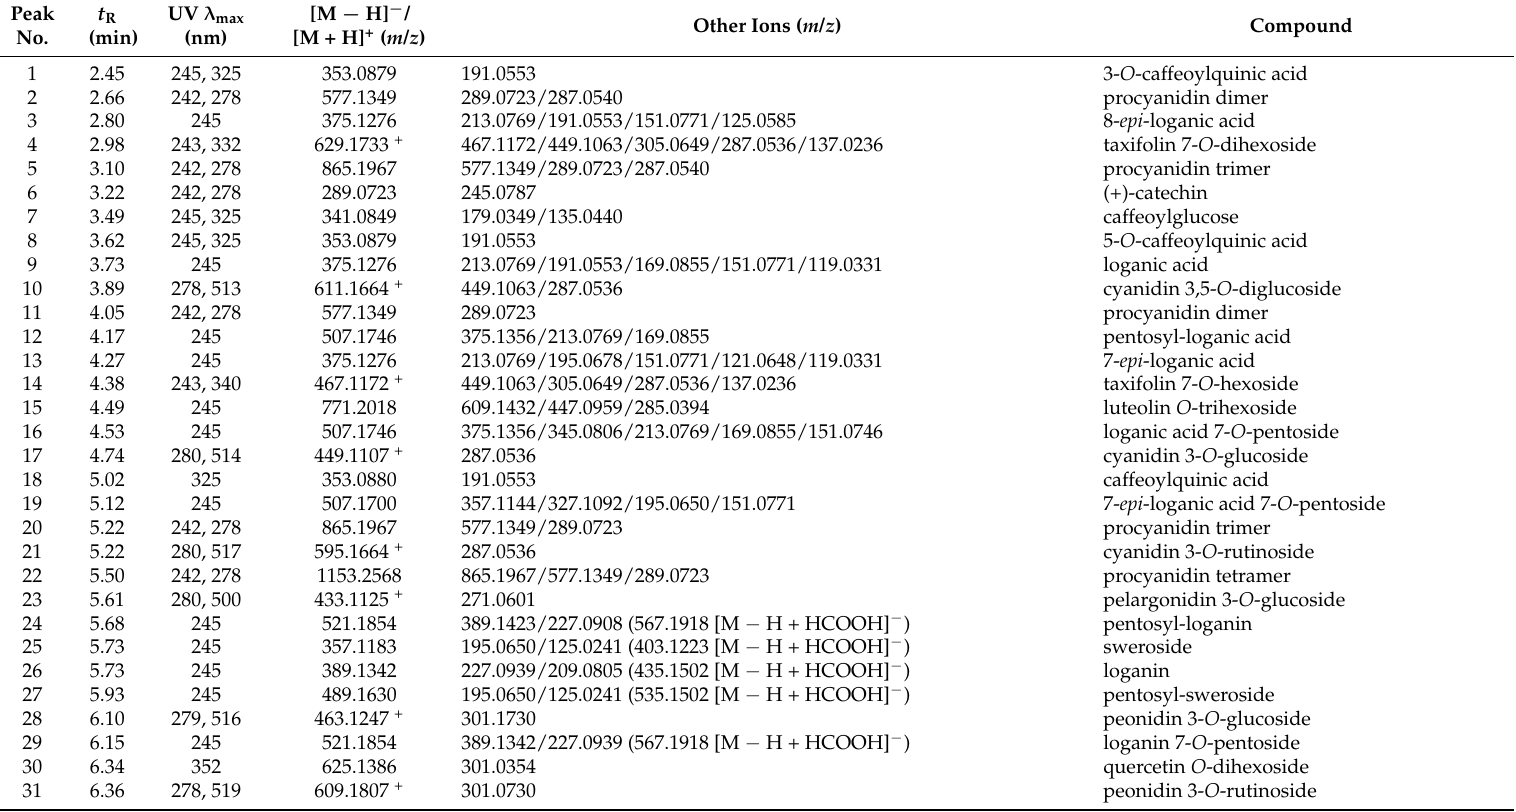
Table 1. Characterization of compounds of honeysuckle fruits determined using their spectral characteristics in positive and negative ions in ultra-performance liquid chromatography coupled with electrospray ionization mass spectrometry (UPLC-ESI-qTOF-MS/MS). Peak